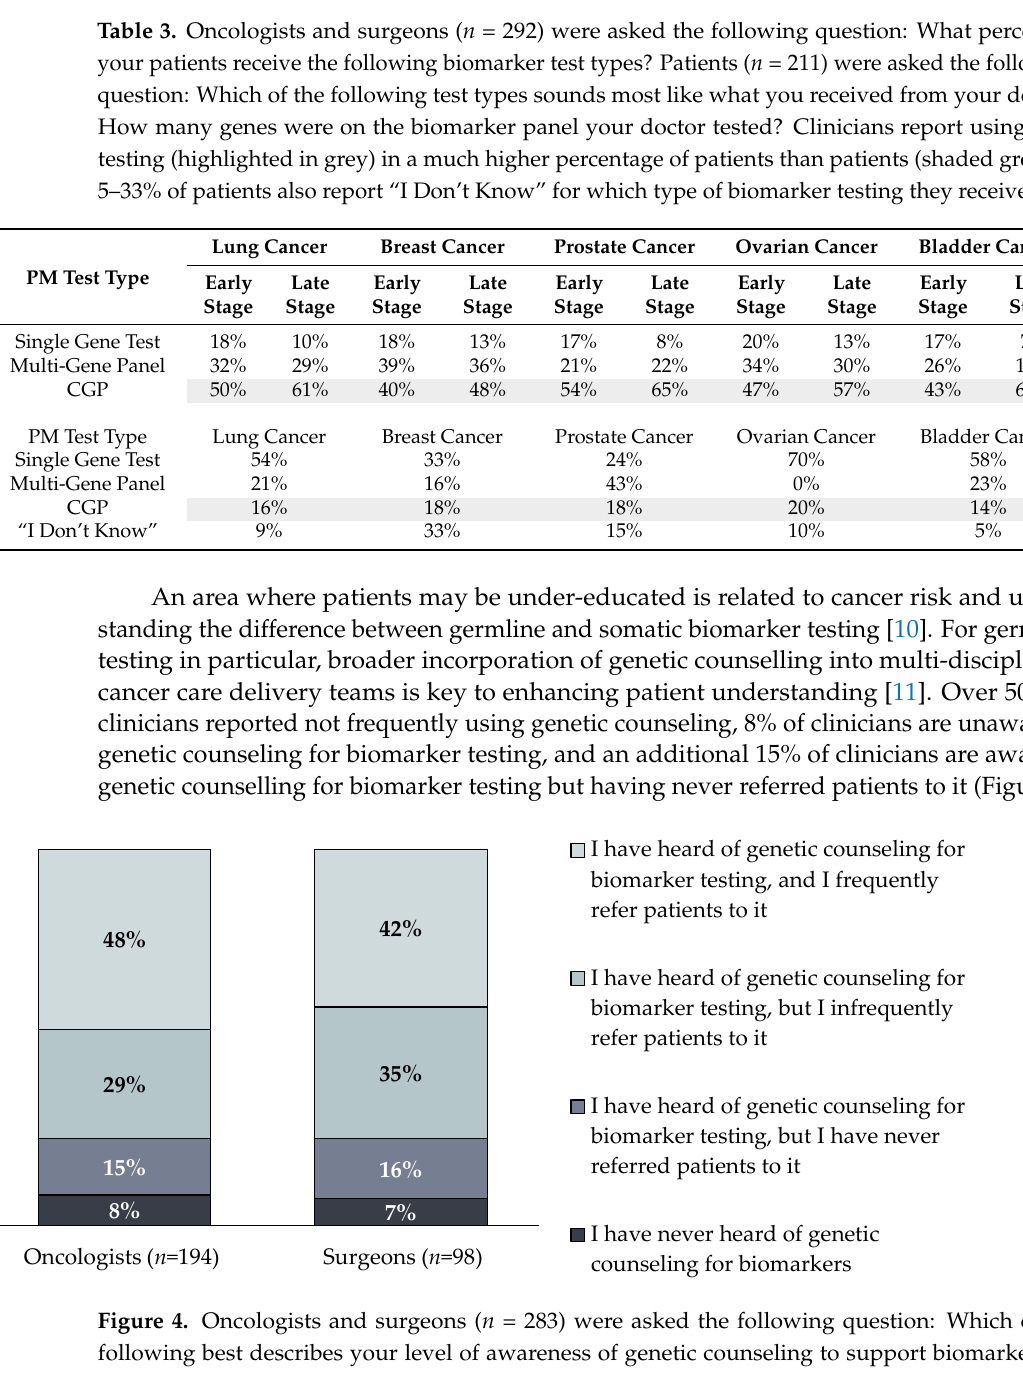
Table 3. Oncologists and surgeons ( n = 292) were asked the following question: What percent of